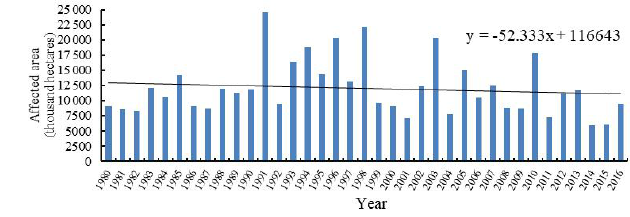
Figure 3. Number of collapsed buildings after flood from 1980– 2016 (MWR, 2007–2016).